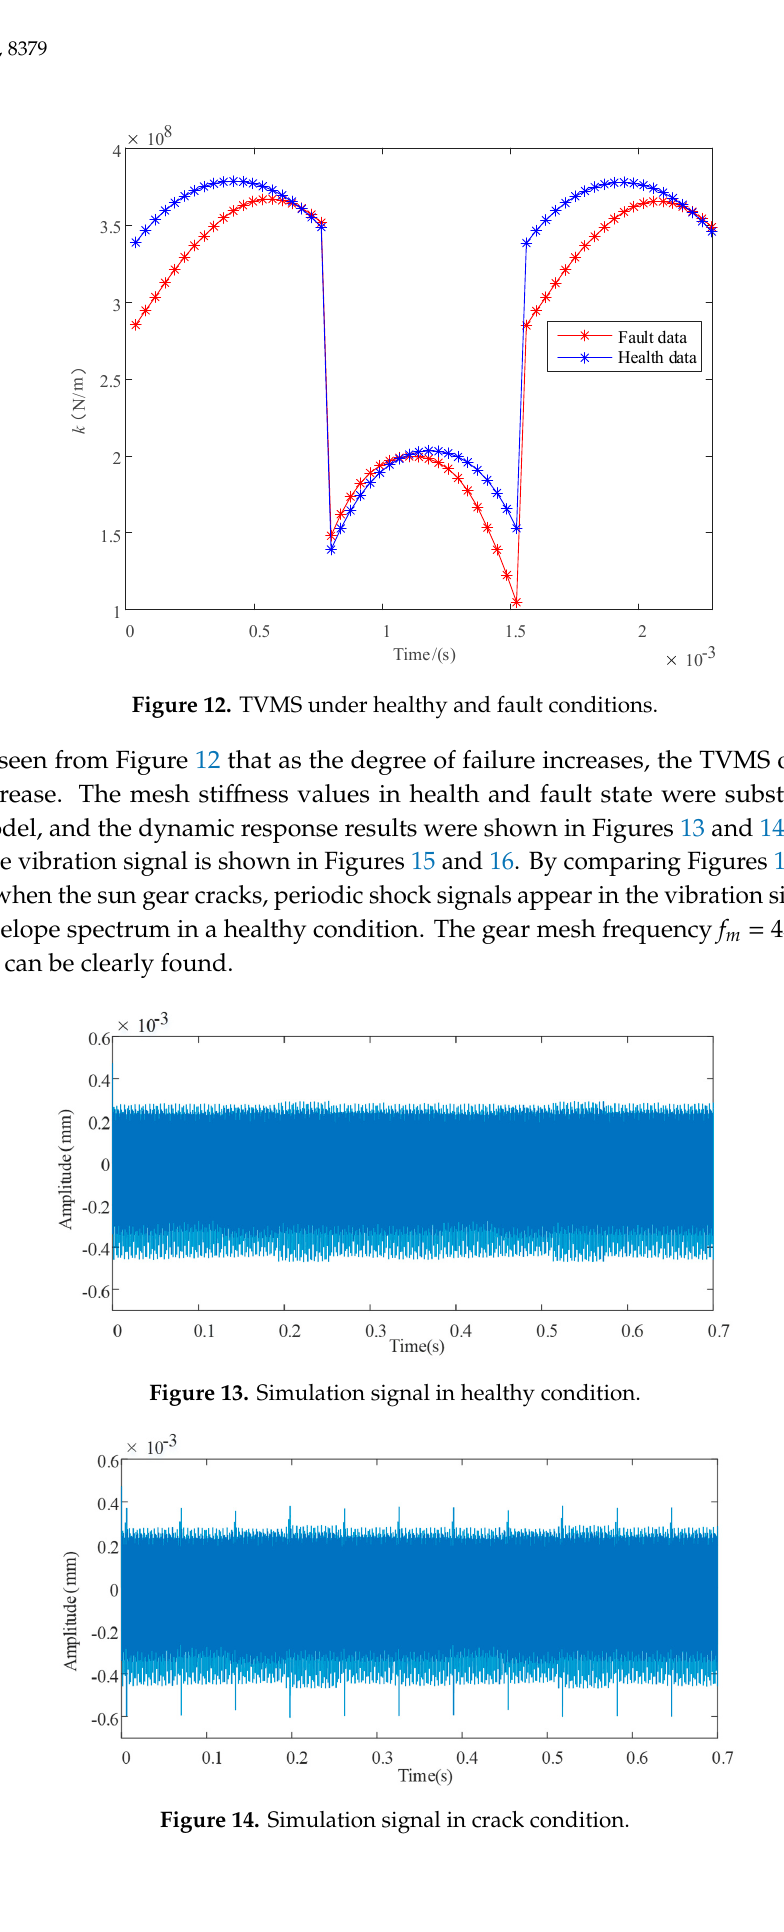
15 of 21 Table 1. Dynamic simulation parameters of the planetary gear train. Parameters